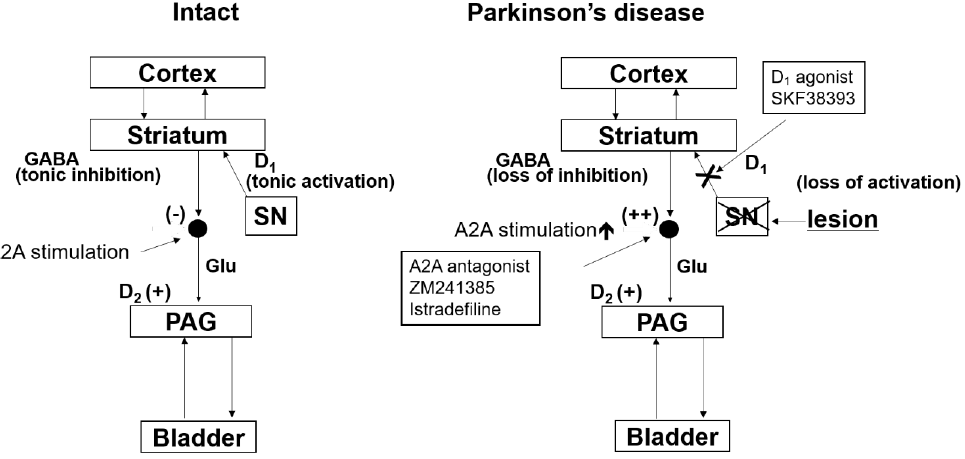
Figure 3. Working model of bladder dysfunction in PD. A hypothetical diagram demonstrates a working model of bladder dysfunction in PD. Micturition reflex is controlled by spinobulbospinal pathways through PAG in the midbrain and PMC in the brainstem. This neural circuit is under the control of higher centers, including the anterior cingulate cortex (ACC) and other cortex regions. (Intact) Under normal conditions, tonic inhibition from ACC suppresses the micturition reflex. Tonic firing (+) of dopaminergic neurons in the substantia nigra pars compacta (SN) activates the dopamine D1 receptors expressed on GABAergic inhibitory neurons in the striatum to induce tonic GABAergic inhibition (−) of the micturition reflex at the level of PAG. At the same time, D1 receptor stimulation suppresses the activity of adenosinergic neurons, which exert an excitatory effect on micturition via adenosine A2A receptors (+). (Parkinson‘s disease) In PD, dopaminergic neurons in the SN are lost (lesion), leading to the loss of dopamine D1 receptors activation (D1 (loss of activation)), which results in reduced activation inhibitory GABAergic neurons in the striatum (GABA (loss of inhibition)). At the same time, reduced D1 receptor stimulation enhances the adenosinergic mechanism to stimulate adenosine A2A receptors (A2A stimulation (++)), leading to facilitation of the spinobulbospinal pathway controlling the micturition reflex pathway. Administration of dopamine D1 receptor agonist (SKF 38393) can restore the GABAergic nerve activity and suppress A2A receptor-mediated activation to reduce bladder overactivity in PD. Furthermore, administration of adenosine A2A antagonists (ZM241385 or istradefylline) can suppress A2A receptor-mediated activation of the micturition reflex to reduce bladder overactivity in PD. Dopamine D2 receptors (D2 (+)) expressed in the spinal cord enhances the micturition reflex.